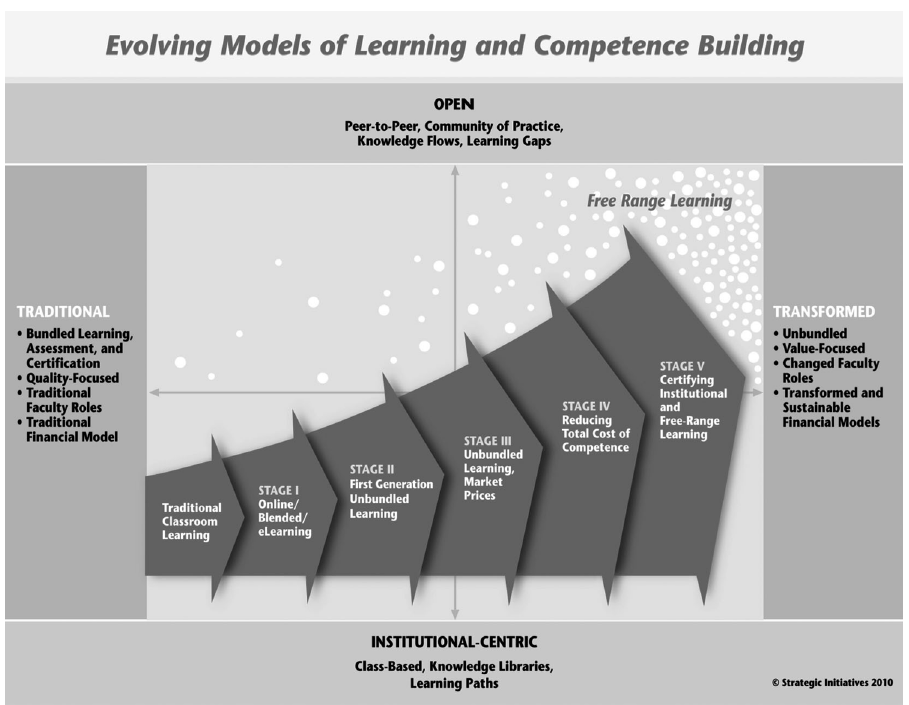
Figure 1. Evolving models of learning and